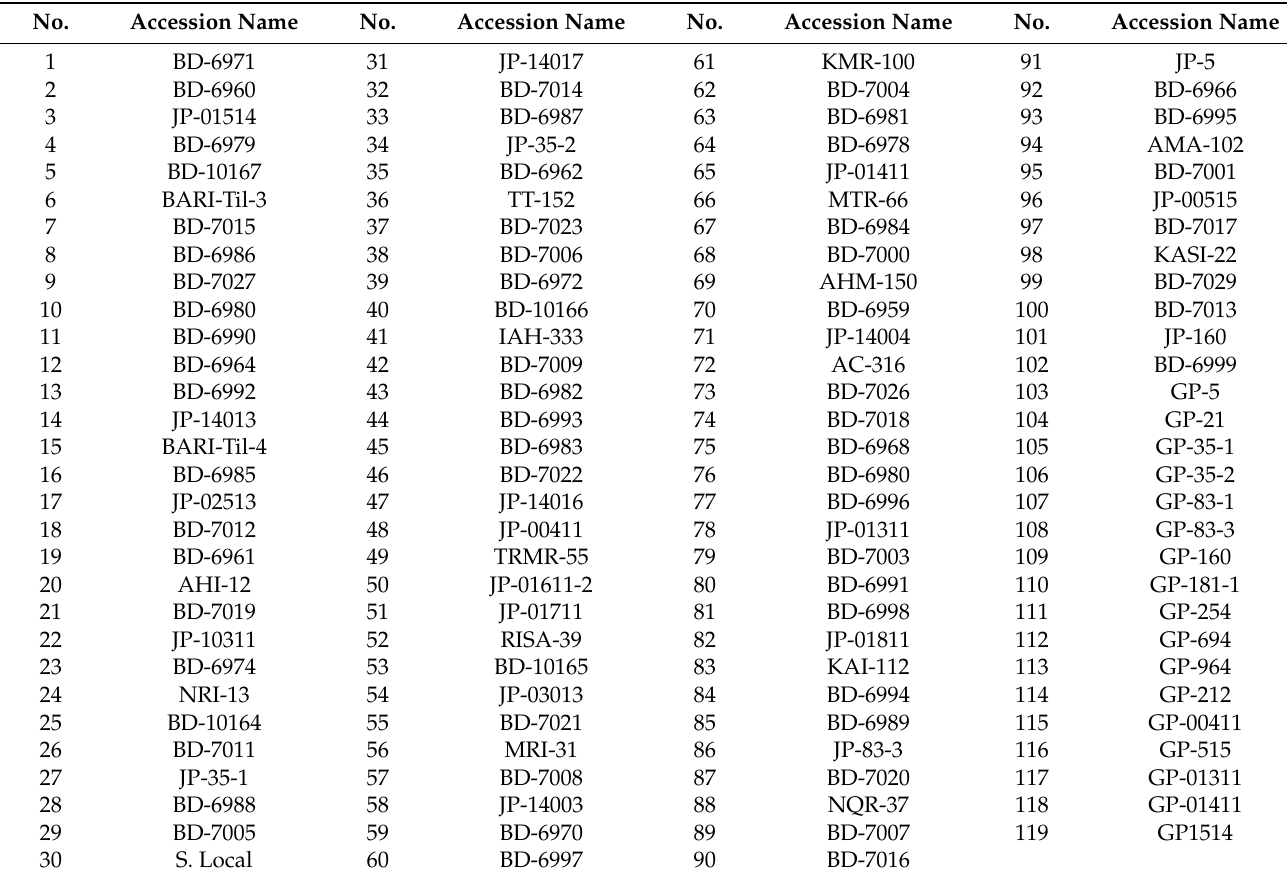
Table 1. List of the evaluated sesame